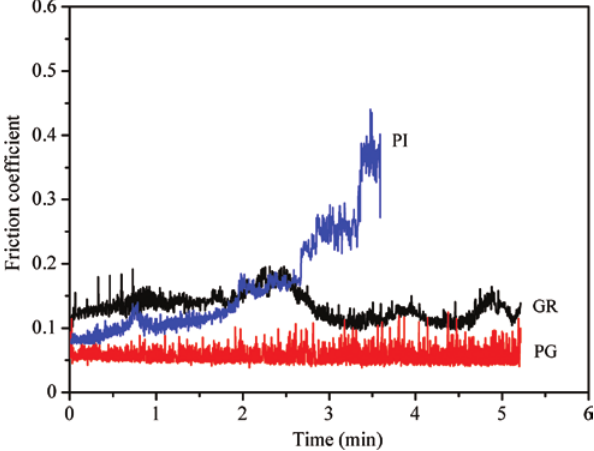
Figure 7: Variation of the friction coefficients of GR, PI, and PG com- posite with sliding time at 400 ° C under the applied load of 300 N.